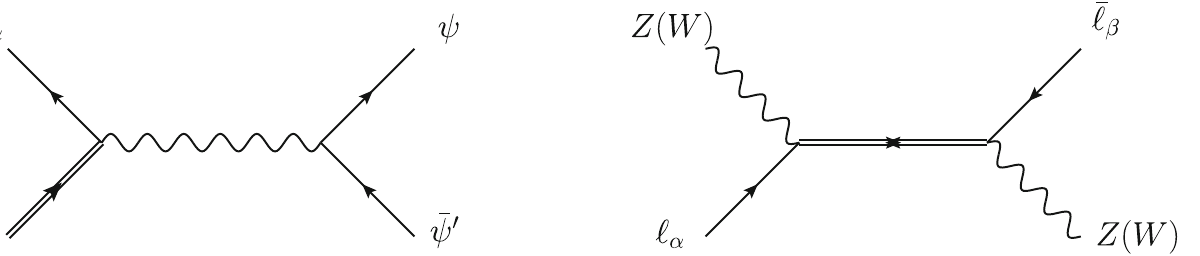
correspond to two and three nearly degenerate neutrinos. The resonant (cid:4) (cid:5) ˜ f ( ˜ f ∗ ) 2 | 2 | ˜ f | 2 ) ≈ 1 imposed at /( | ˜ f conditions (cid:16) = (cid:15) I / 2 and Im I J J I the same time [58]. The blue dotted-dashed line stands for the hierarchi- / M = 0 . 1. The grey band originates from uncertain- cal case, with M ∗ i 1 ties in the value of the baryon asymmetry, efficiency factors